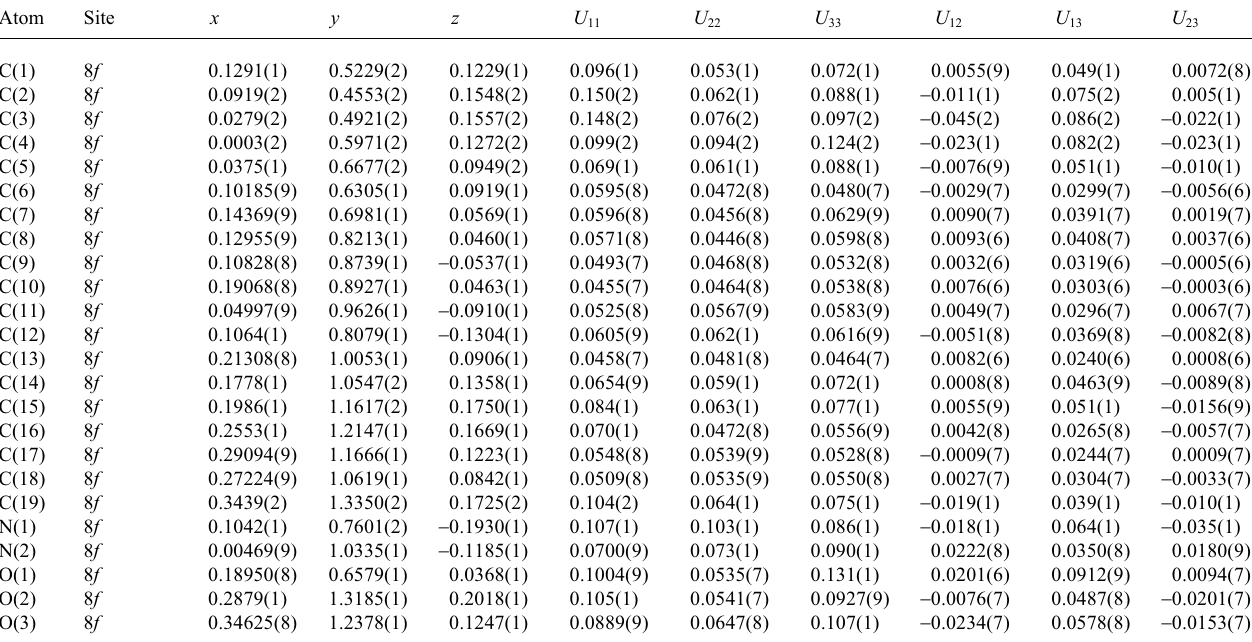
Table 3. Atomic coordinates and displacement parameters (in Å 2 )